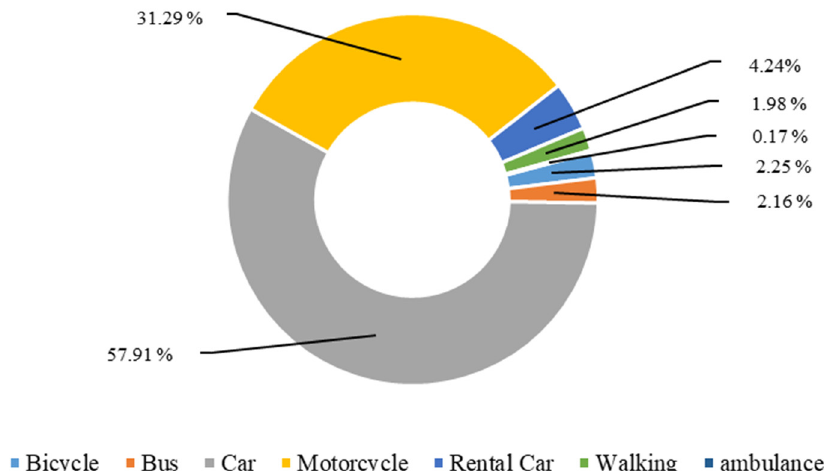
Figure 1. Type of vehicles used for transport to outpatient health care facilities during the past six months.